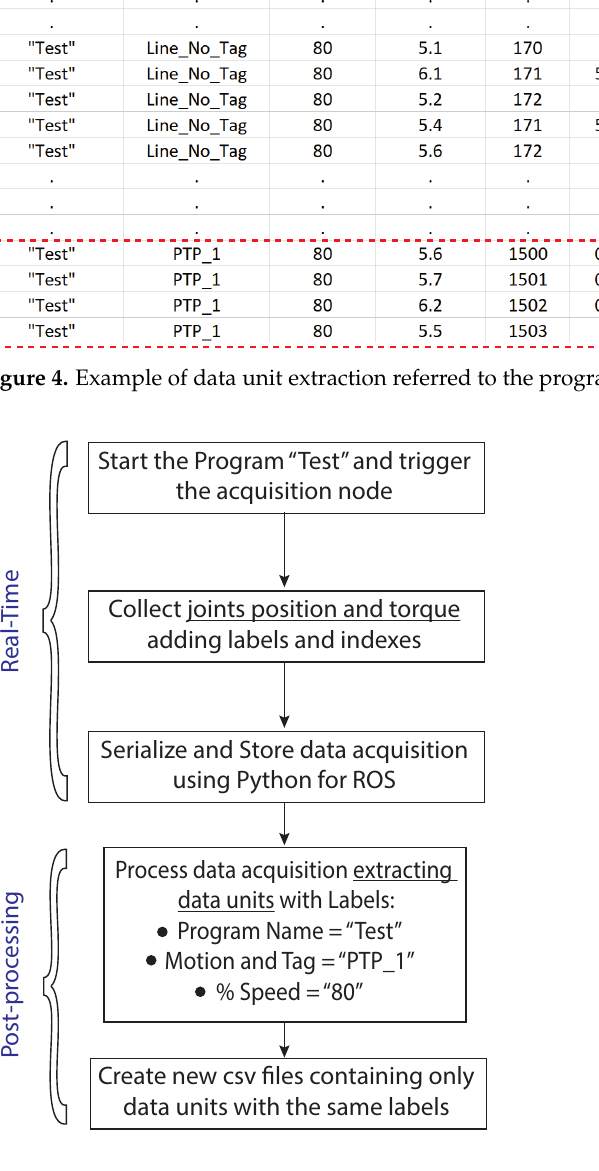
Figure 5. Flowchart representing the steps to extract data units during program